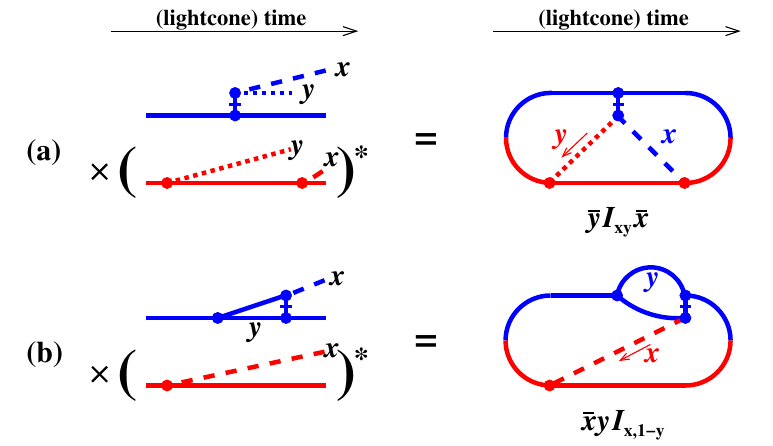
Figure 8 . Specific examples of instantaneous diagrams (depicted here in just one of the three possible channels) that are included in the (a) ¯ yF ¯ x diagram of figure 4 and (b) ¯ xyF diagram of figure